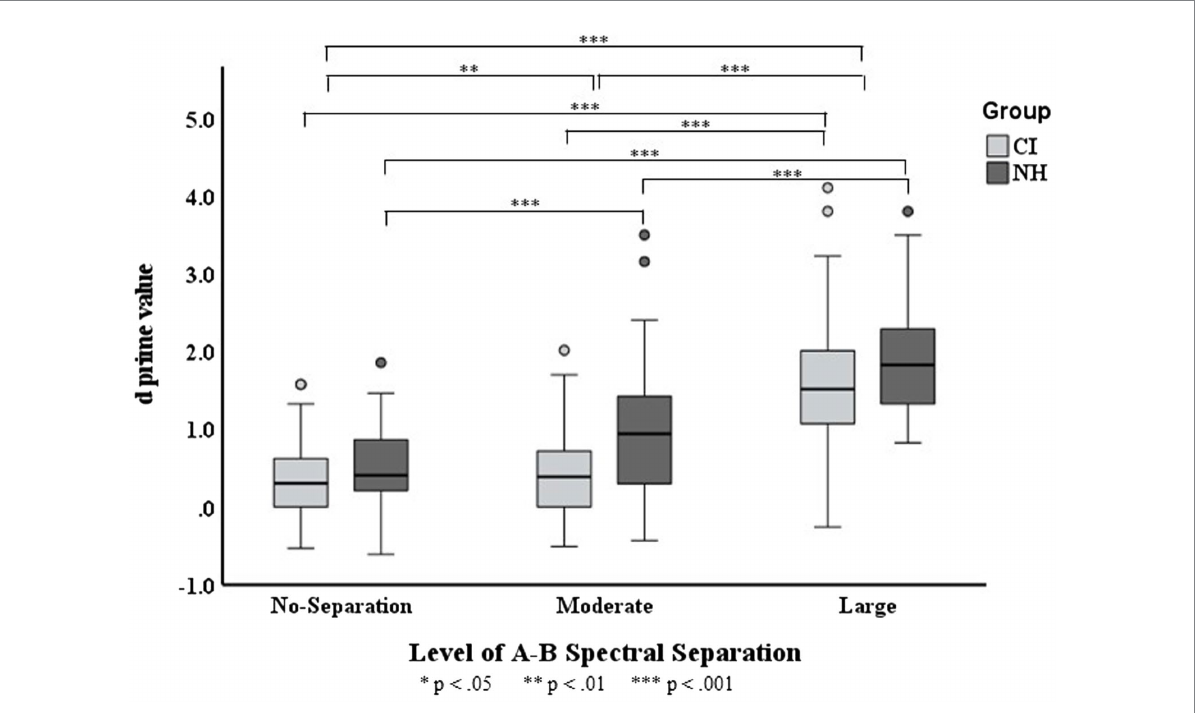
FIGURE 4 Boxplots for d ¢ values across three A–B spectral separations in the CI and NH groups. The boxes show the 25–75th percentile, the error bars show the 5 and 95th percentile, the circle symbols show outliers, the solid horizontal line shows median performance. The statistically significant differences reported in the Results is indicated by